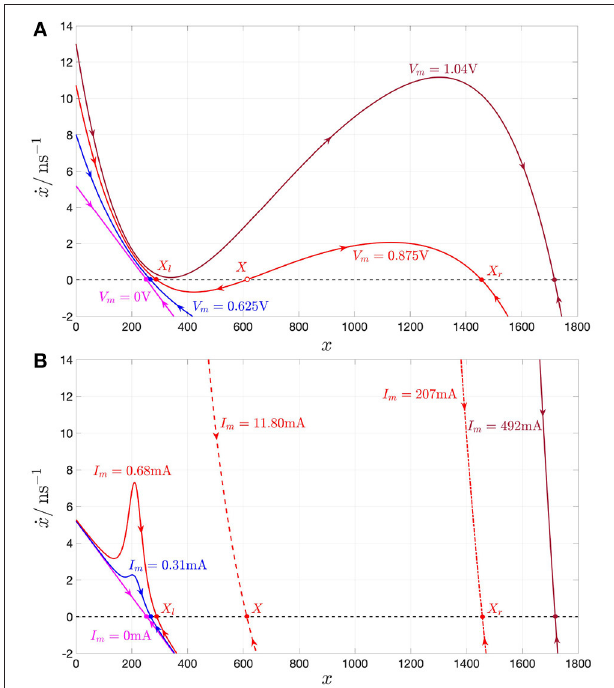
FIGURE 4 | (A) DRM of the NbO memristor under voltage control for each V m , 0,0.625,0.875,1.04 V. (B) DRM of the NbO value in the set S V m { } memristor under current control for each I m value in the set , S I 0,0.31,0.68,11.80,207,492 mA. Analyzing the V m range m { } [0V,1.046V], shown in the DC I m – V m characteristic of Figure 2C , the